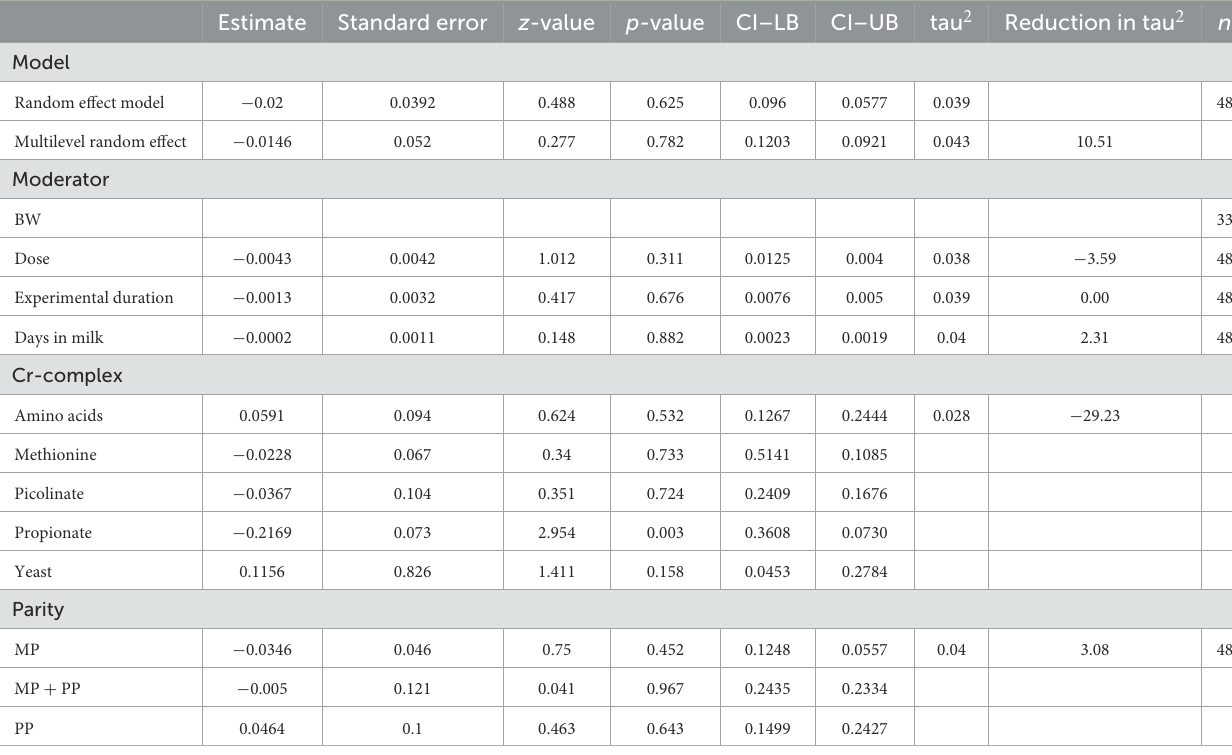
TABLE 4 A summary of statistical models and moderators for the milk fat